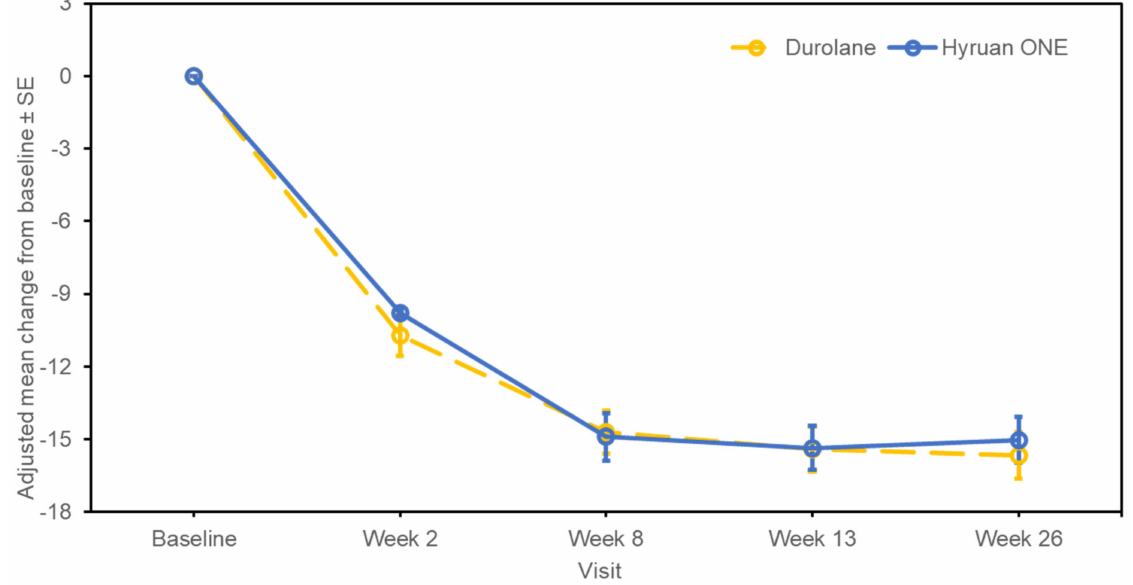
Figure 4. Western Ontario and McMaster Universities–Likert Physical Function sub-score changes from baseline to post-injection (per-protocol set). SE, standard